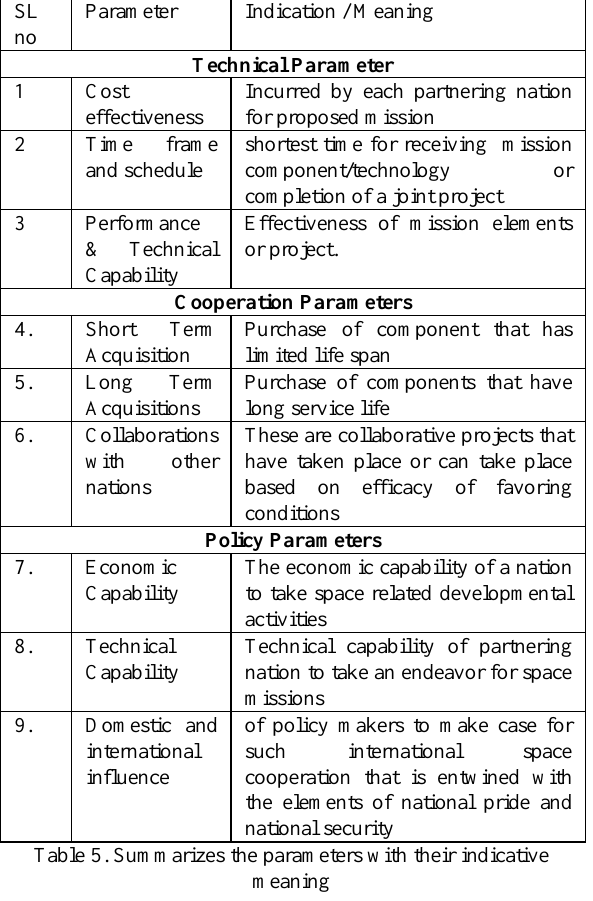
meaning A Fuzzy cognitive map in Fig. 4 is depicting the inter- relationship of different parameters/ variable with positive and negative indicators. Red Line indicates negative relation between affected and causal variables; Blue Line indicates positive relationship between affected and causal variables.